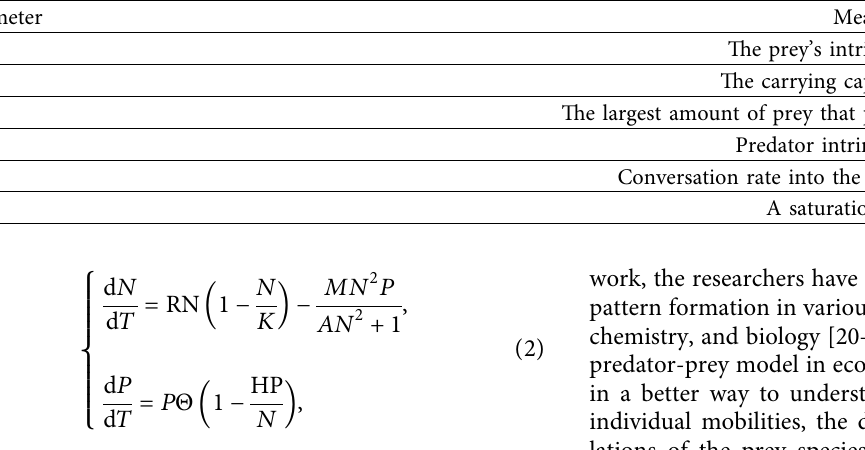
Table 1: The definition of parameters used in model